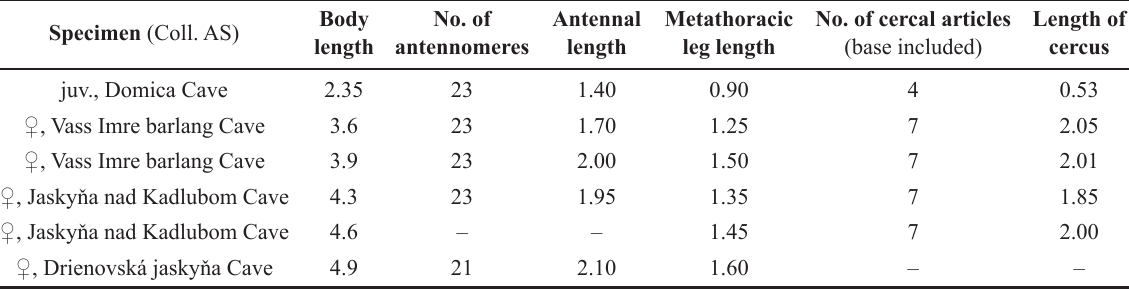
Table 10. Plusiocampa ( Plusiocampa ) spelaea Stach, 1930. Length of the body, antennae, metathoracic legs and cerci (measurements in mm), in addition to the number of antennomeres and cercal articles. Specimen (Coll.